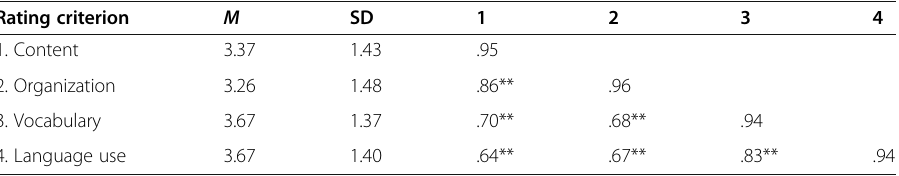
Table 9 Correlations for novice ratings (random) Rating criterion